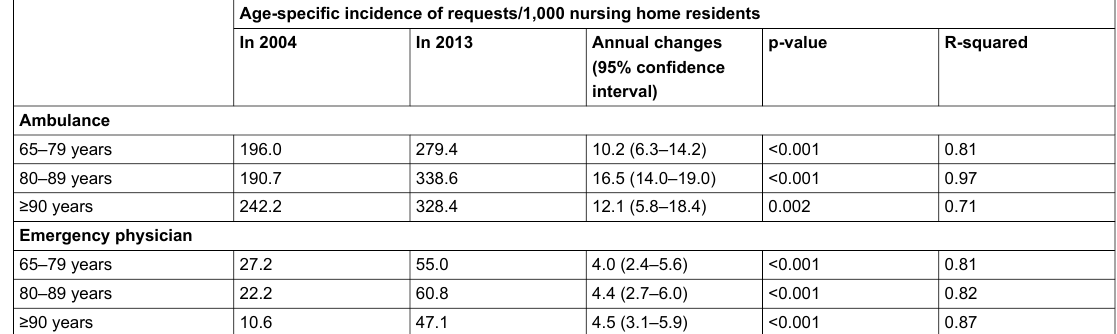
Table 5: Age-specific annual linear changes in incidence of requests to ambulance or emergency